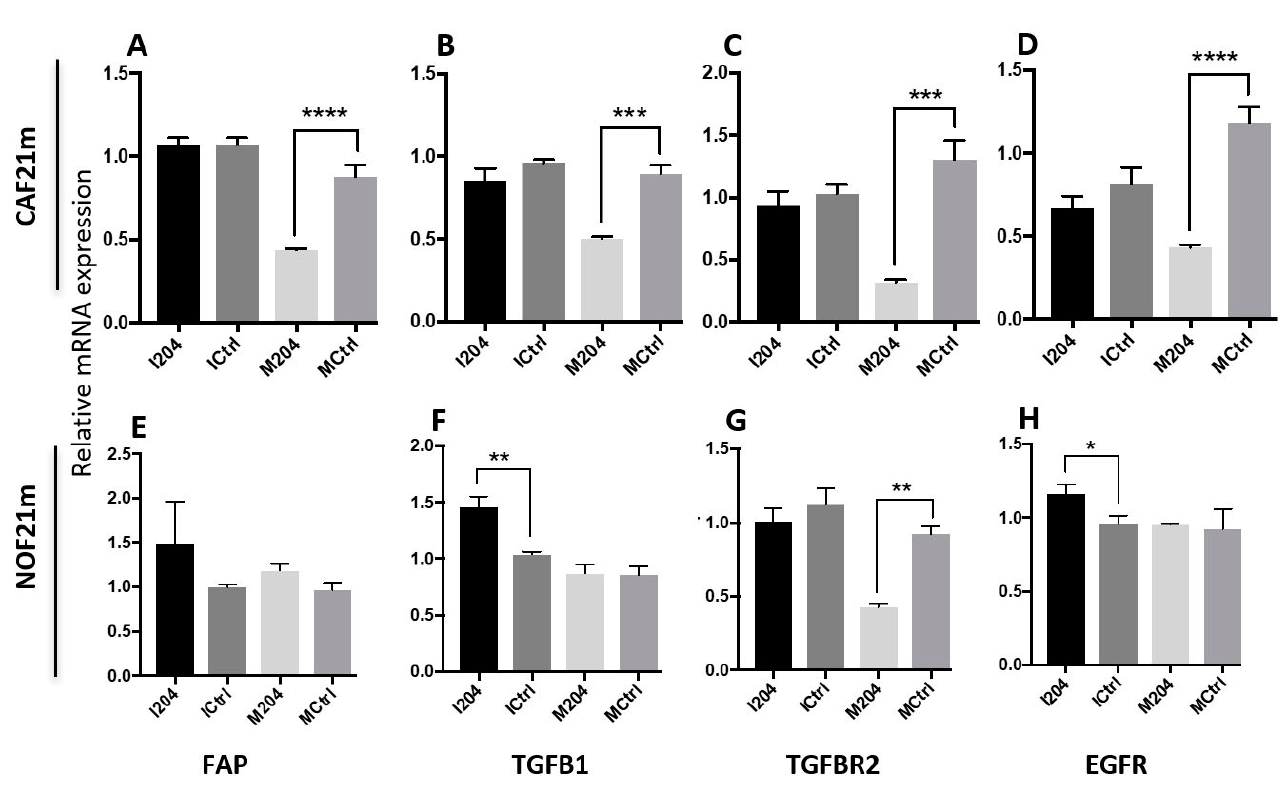
Figure 4. Regulation of CAF-related transcripts by miR-204 ((* p < 0.05, ** p < 0.005, *** p < 0.0005, and **** p < 0.0001, unpaired Student’s t -test, n = 3). ( A , E ) FAP expression; ( B , F ) TGFB1 expression; ( C , G ) TGFB2 expression; and ( D , H ) EGFR expression in CAF21m and NOF21m respectively.